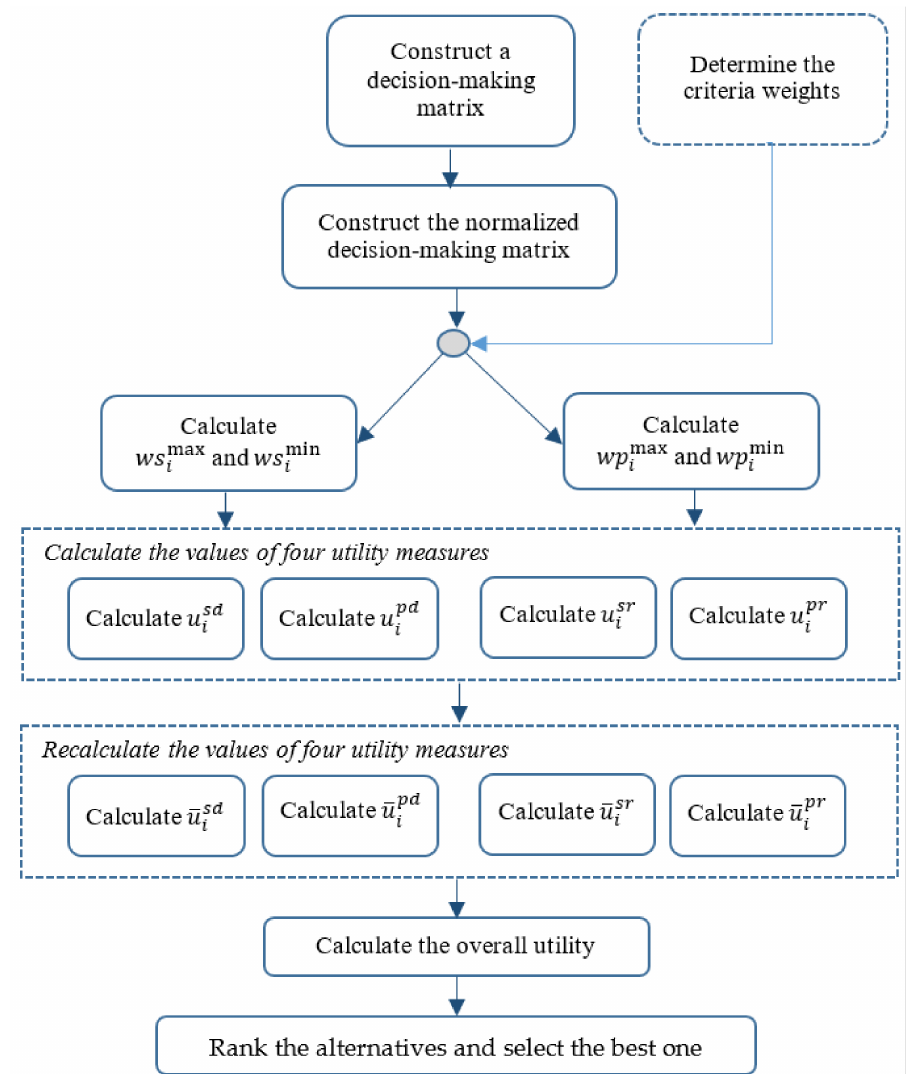
Figure 1. The computational procedure of the WISP